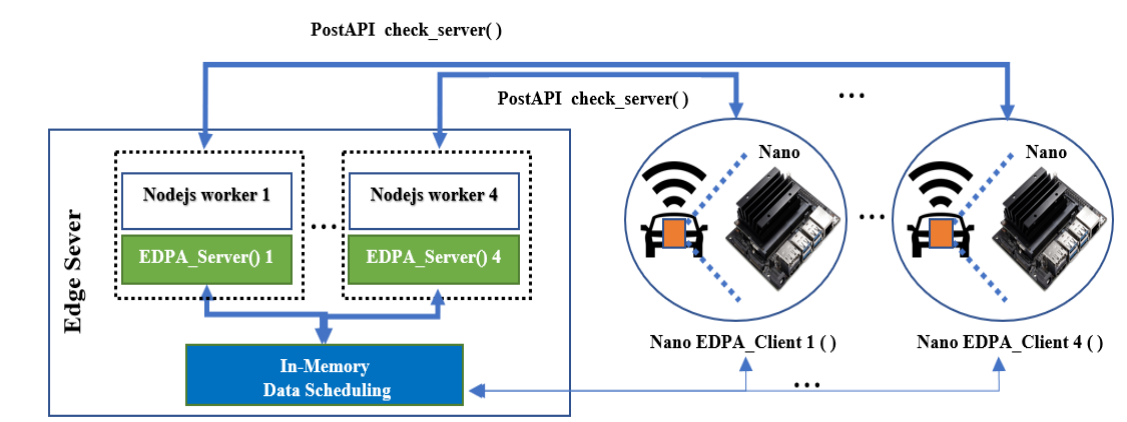
Figure 5. The prototype, including hardware and software settings of the proposed distributed